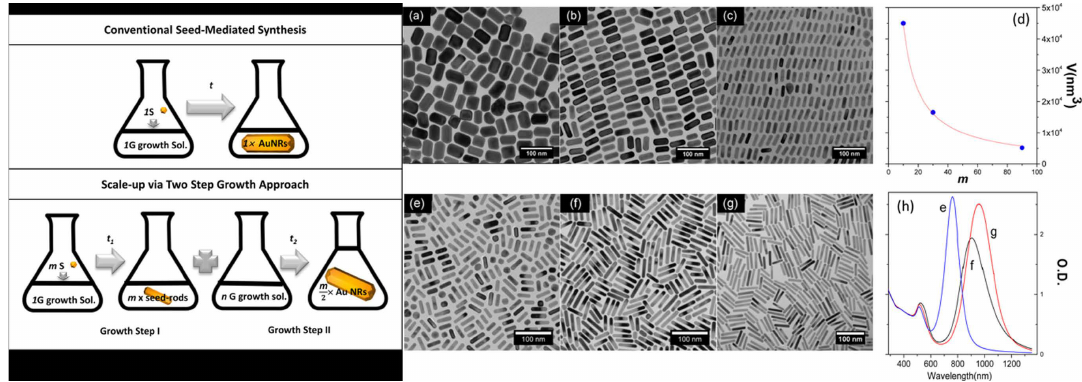
Figure 3. Left: Comparing the conventional seed-mediated protocol and the two steps approach. Right: TEM images, scale bars 100 nm. ( a – c ) Different AuNR volume in function of seed concentration. ( d ) Correlation between seed concentration scaling factor (m) and the final AuNR volume (V). ( e – g ) Effect of the change of surfactant in the second growth solution on the AuNR aspect ratio. ( h ) UV-vis spectra of the AuNRs e–g. Reproduced from [30] with permission from the American Chemical